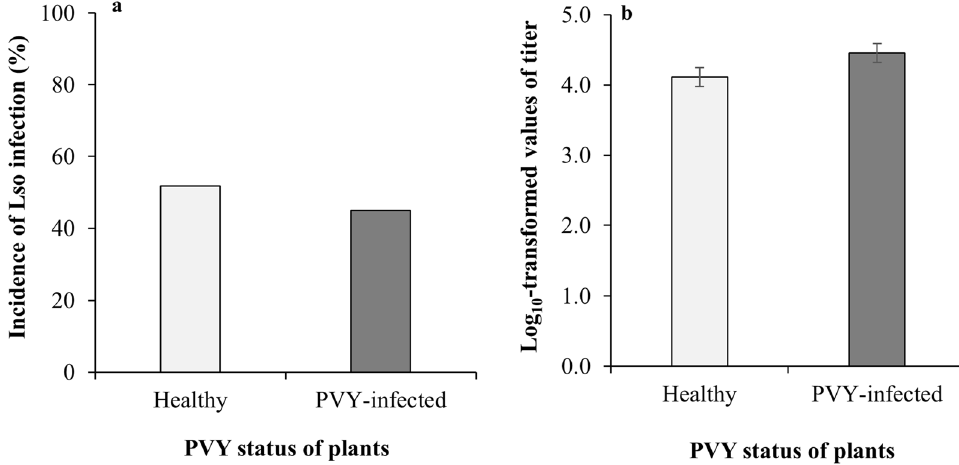
Figure 1. “ Candidatus Liberibacter solanacerum” in healthy and PVY-infected tomato plants demonstrating no significant difference in either ( a ) transmission success across time-blocks, or ( b ) titers. Error bars represent standard error (± SE).